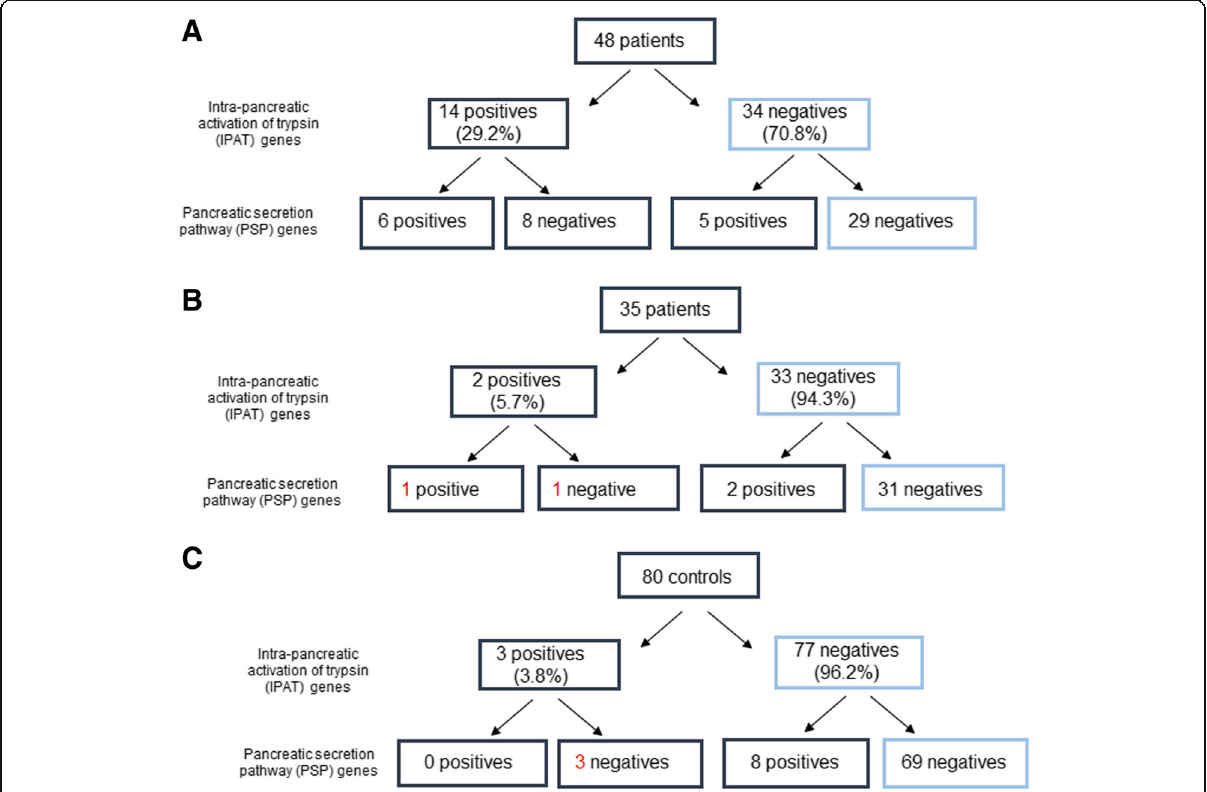
Fig. 1 Flowchart of the results of molecular analysis in 48 patients affected by CF and recurrent/chronic pancreatitis ( a ), in 35 patients with CF and without pancreatitis ( b ) and in 80 healthy subjects ( c )